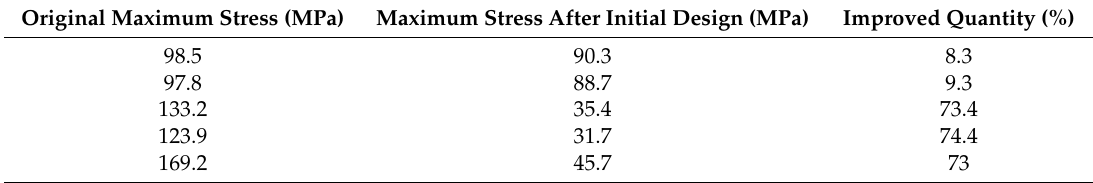
Figure 4. CAD and FEM model of middle product: ( a ) CAD model of side A ( b ) CAD model of side B ( c ) FEM model of side A ( d ) FEM model of side B. Table 4. Results of strength analysis after initial design of end cap. Table 4. Results of strength analysis after initial design of end cap.